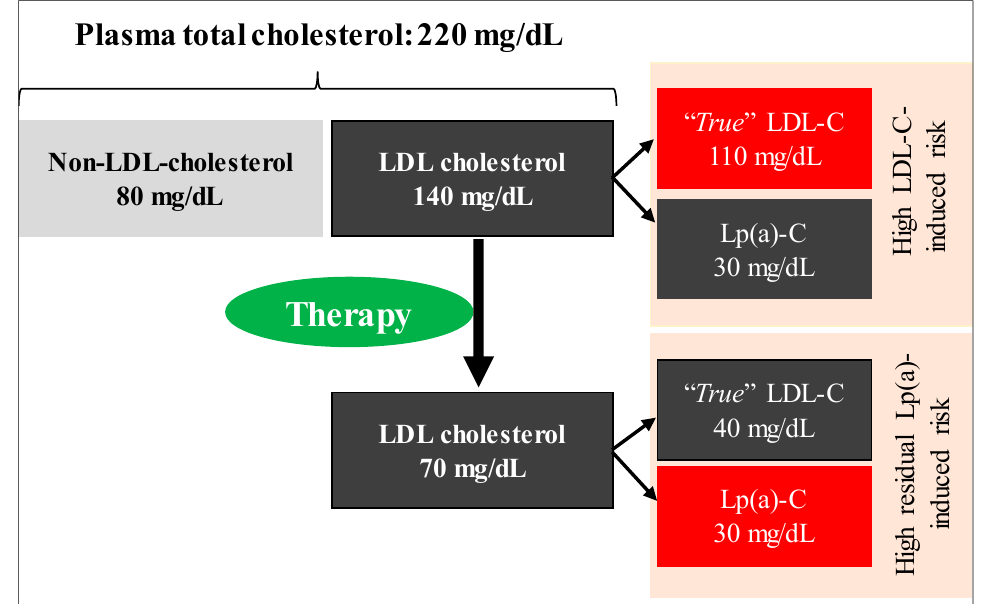
Figure 3. A hypothetical case describing the Lp(a)-associated residual cardiovascular risk following a therapy. Clinical measurement of LDL-C includes cholesterol carried on Lp(a) (~30% of Lp(a) mass). An individual with an LDL-C level of 140 mg/dL, which includes 30 mg/dL cholesterol carried on Lp(a), reduced LDL-C to 70 mg/dL with a therapy. While LDL-C-attributable CVD risk is controlled, Lp(a)-associated residual risk remains high. Lowering dietary saturated fat intake, which is a recommended therapy, increases Lp(a) concentration, thus may promote Lp(a)-induced residual risk even further.